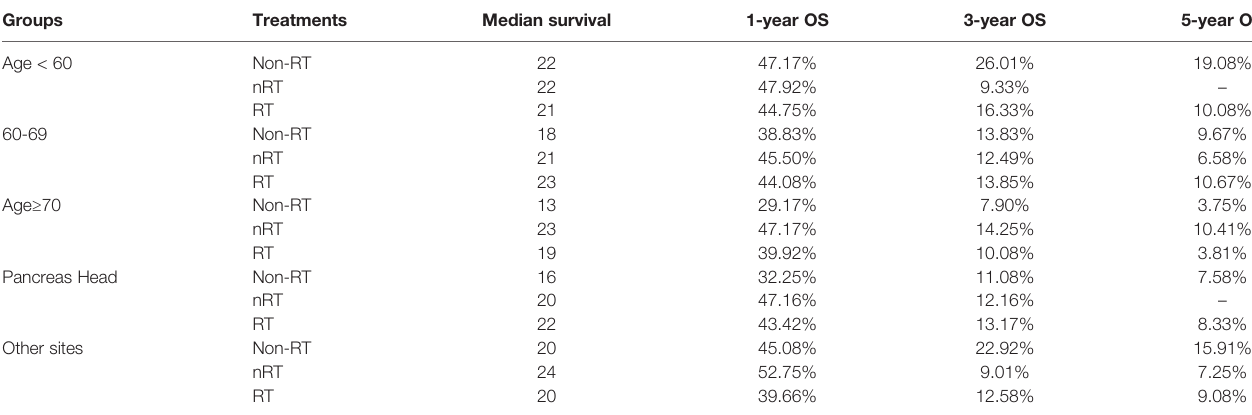
TABLE 3 | Median survival and, 1-, 3- and 5-year OS of stage IIB/III PDAC patients. Groups